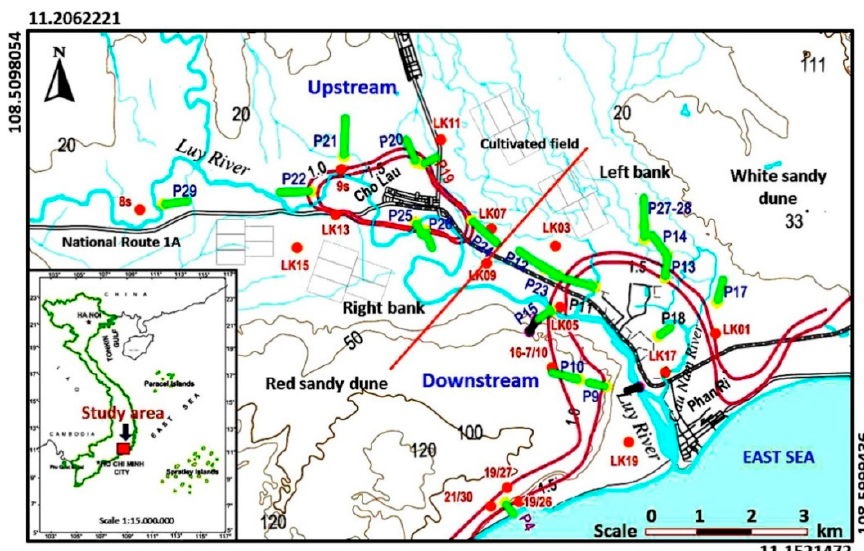
Figure 1. Location of study area (red rectangle) and 21 collected ERT profiles (green lines; the yellow points indicate the origin of the profile with the 1st electrode at 0m) and boreholes (red circles). The red solid line indicates the limit between the upstream and downstream parts of our study area. The two purple solid lines correspond to saline boundaries with a TDS limit = 1.5 g/L and 1.0 g/L from well measurements obtained by NAWAPI (2015) [34]. Topographical isolines (in m above sea level) are shown by brown curves.